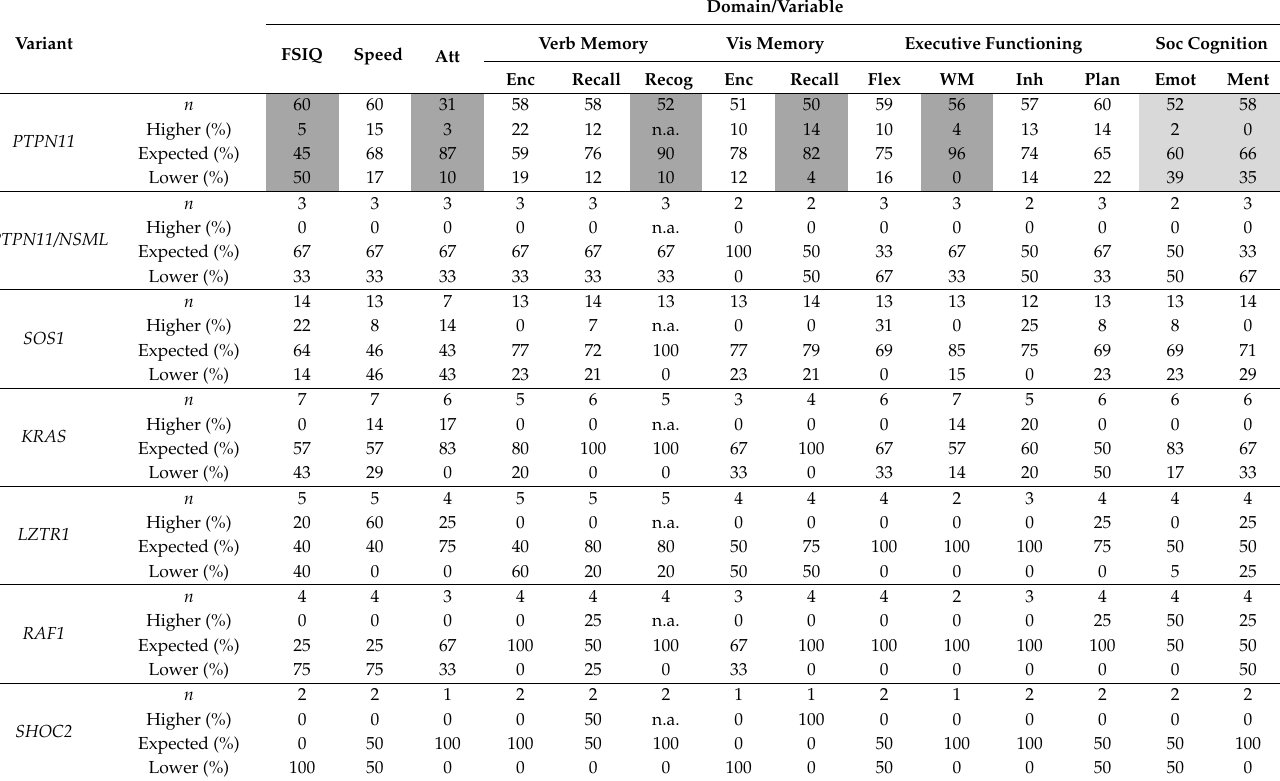
Table 3. Descriptive classifications for the cognitive domains per variant